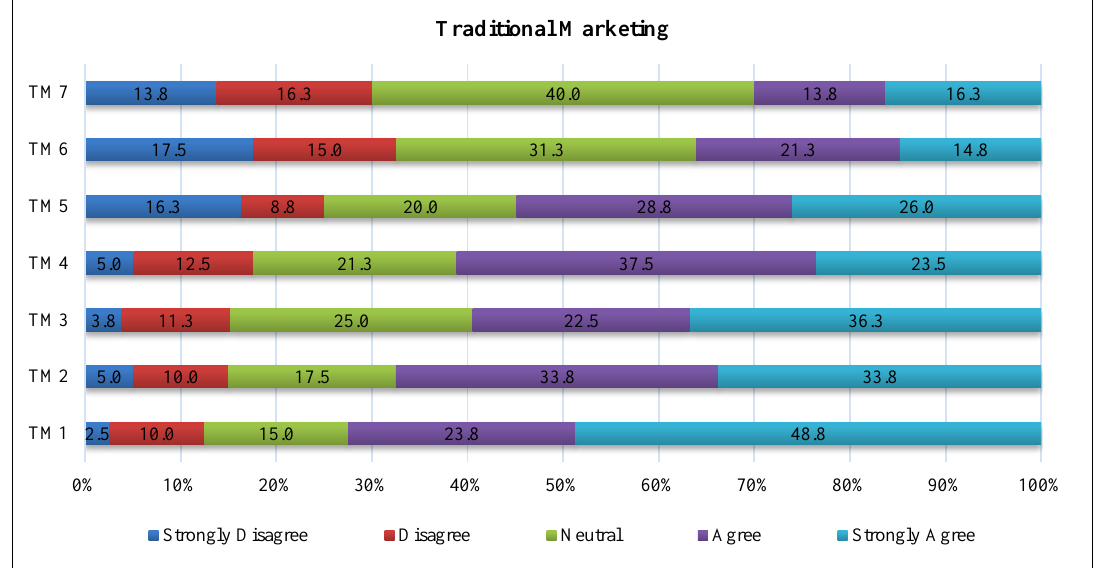
Figure 4. Level of agreement for Traditional Marketing